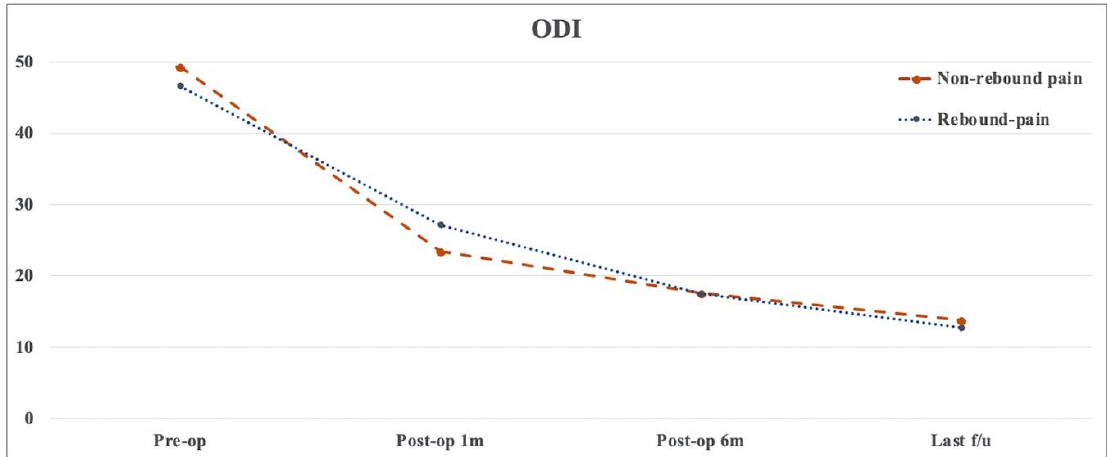
Figure 4. Changes in the Oswestry disability index scores with time for the non-rebound and rebound pain groups.